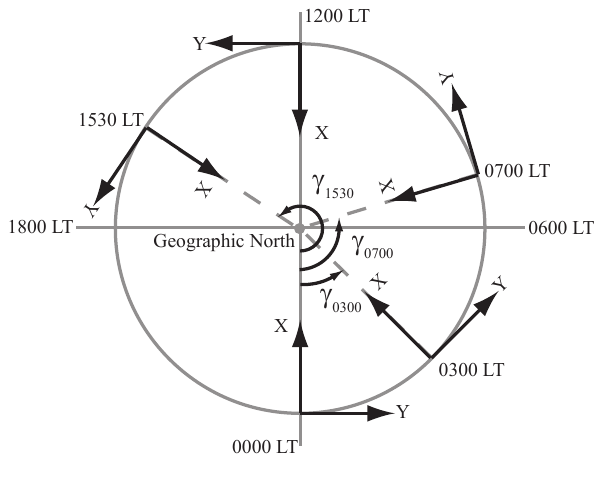
Fig. 2. Rotating geographic coordinate system.